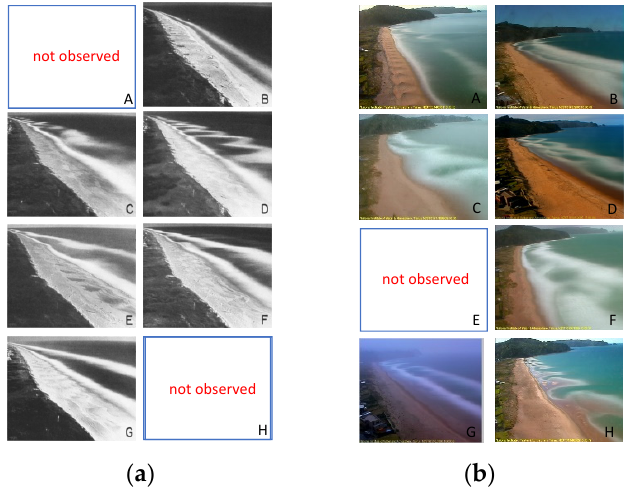
Figure 1. Comparison of Lippmann’s classification (Adapted with permission from Ref. [3]. © 2021 John Wiley and Sons.) ( a ) and the classification in this paper ( b ). There are eight classes: (A) reflective, no offshore bar, and lack of wave breaking; (B) incident scaled bar, little longshore variability, and low tide terrace; (C) non-rhythmic, attached bar, no coherent longshore rhythmic; (D) attached rhythmic bar, rhythmic bar line, and discontinuous trough; (E) offshore rhythmic bar, rhythmic bar line, and continuous trough; (F) non-rhythmic, 3-D bar, longshore variable, non-rhythmic, and continuous trough; (G) infragravity scaled 2-D bar, no longshore variable; (H) dissipative, flat beach slope.